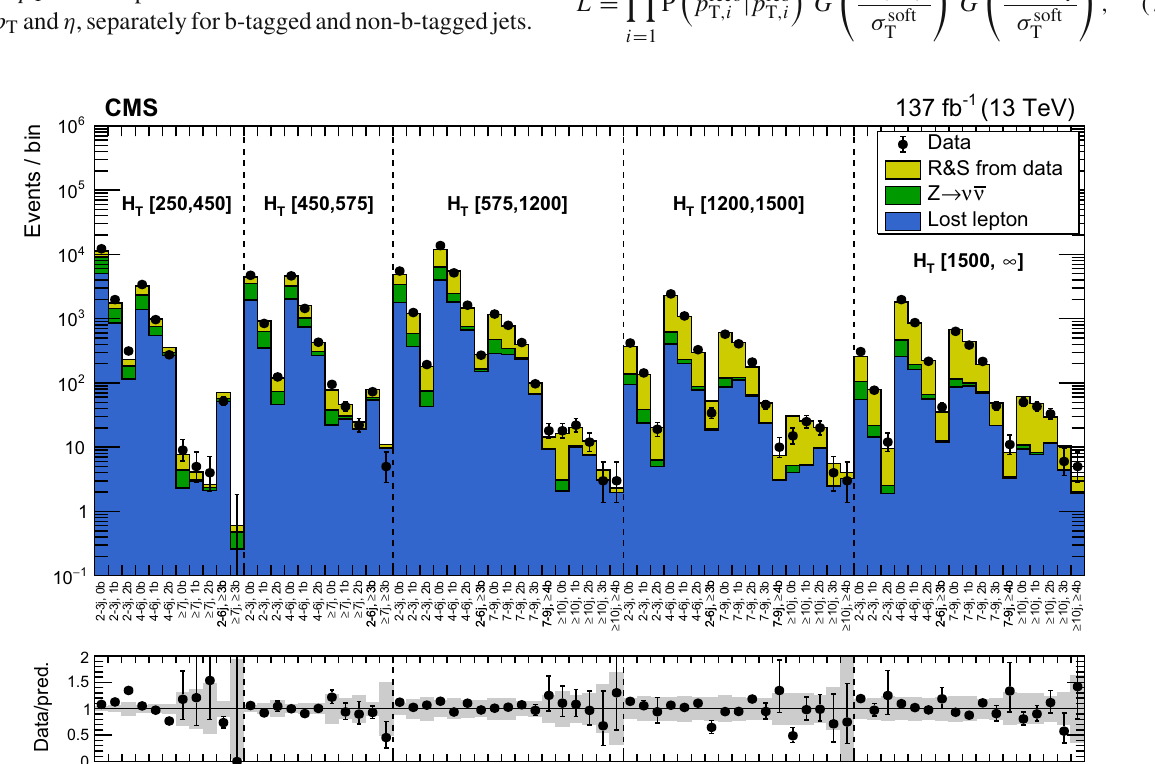
Fig. 3 ValidationoftheR&Smultijetbackgroundpredictionincontrol regions in data selected with Δφ min < 0 . 3. Electroweak backgrounds (LL and Z → ν ¯ ν ) are estimated from data. In regions where the amount of data is insufficient to estimate the electroweak backgrounds, the cor-